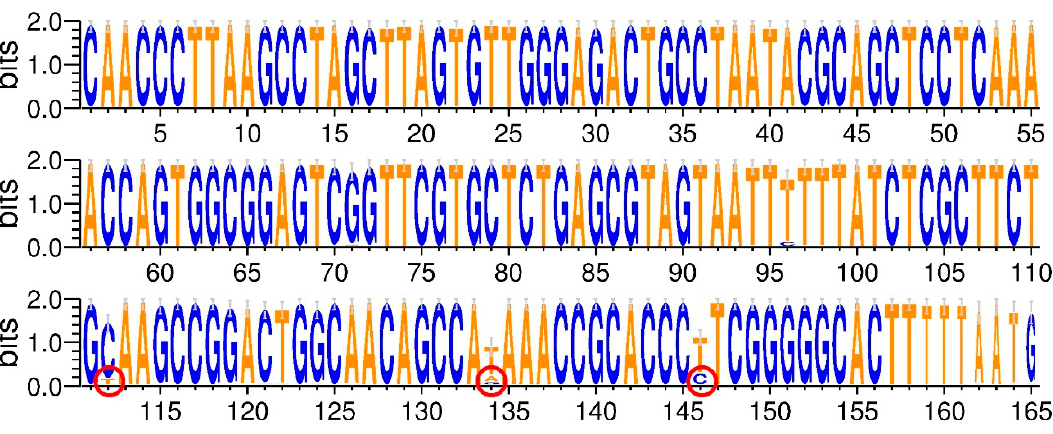
Figure 8. WebLogo3 visualization of ClustralW multiple alignment of 164 bp fragments of ITS2 of 24 Microdochium majus and 85 M. nivale sensu stricto strains. Some (32 of 85) of the M. nivale sensu stricto strains have species-specific positions (T112, A / G134, and C146; marked by red circle) that distinguish them from all known M. majus strains. Other M. nivale sensu stricto strains (53 of 85) have the same nucleotide positions as all M. majus strains (C112, T134, and T146).